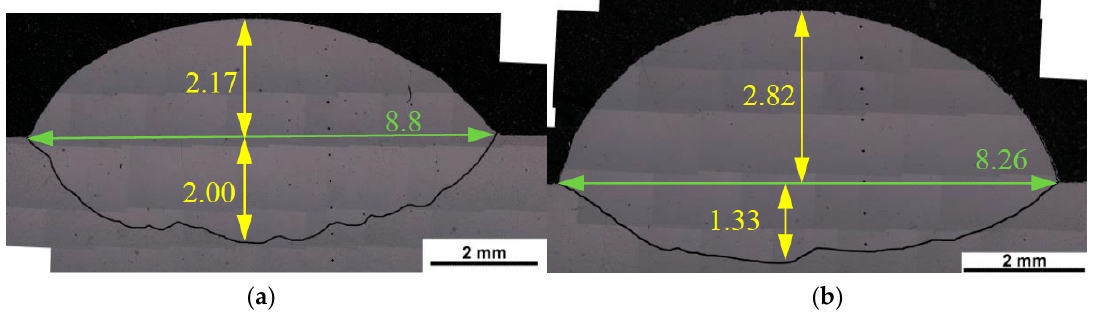
Table 2. The roughness parameters of the weld surface.